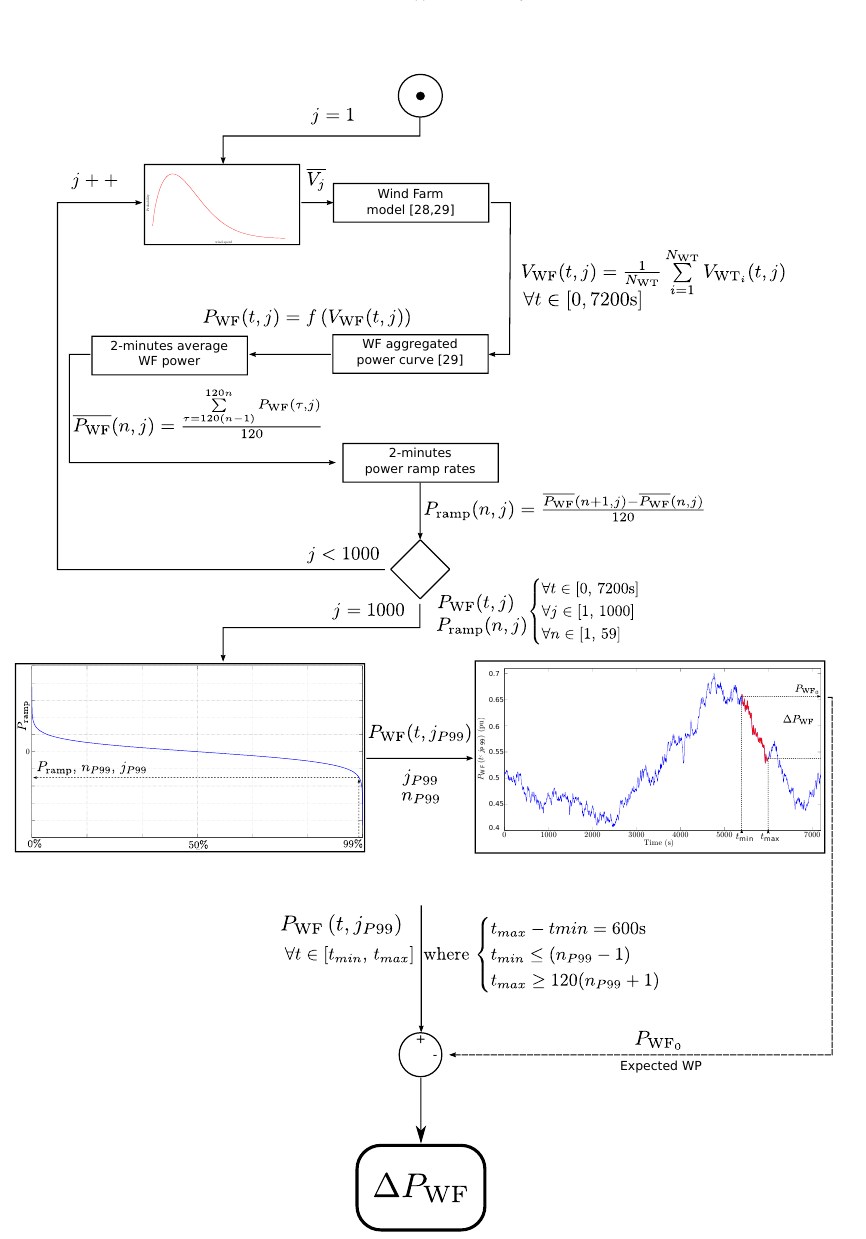
Figure 8. Sketch of the algorithm used for the simulation of critical wind power